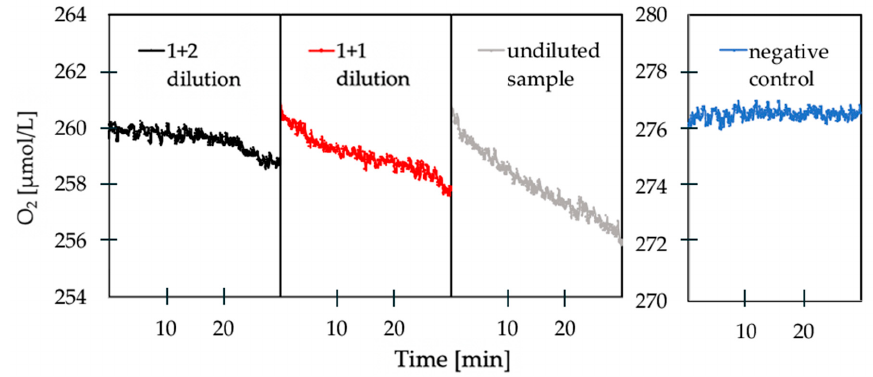
Figure 5. Examples of measured oxygen respiration of an undiluted sample, a 1 + 1 diluted sample and a 1 + 2 diluted sample compared to the negative control.